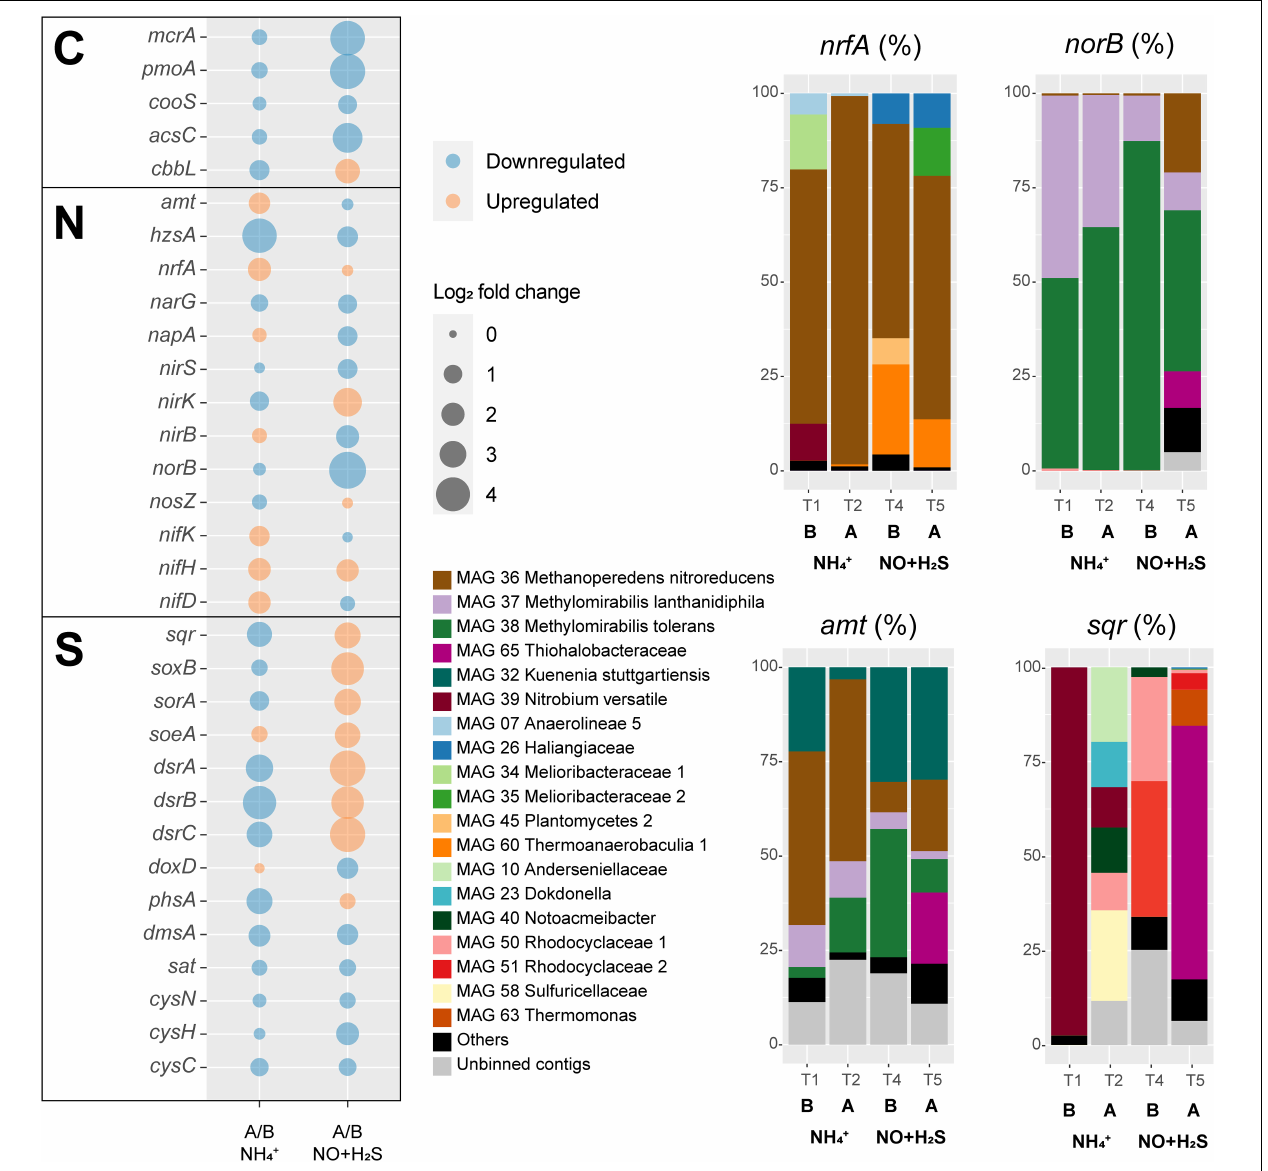
FIGURE 5 | Transcriptional responses to ammonium removal and sulfide and NO toxicity experiments. Left: log2 fold change, as well as upregulation or downregulation of genes encoding proteins involved in carbon (C), sulfur (S), and nitrogen (N) cycling. In this analysis, all binned and unbinned contigs were analyzed together. Right: taxonomic contribution to selected gene transcripts of MAGs and unbinned contigs. Under norB , subunits of putative nitric oxide dismutases are also included. Abbreviations are as follows: B, before; A, after.